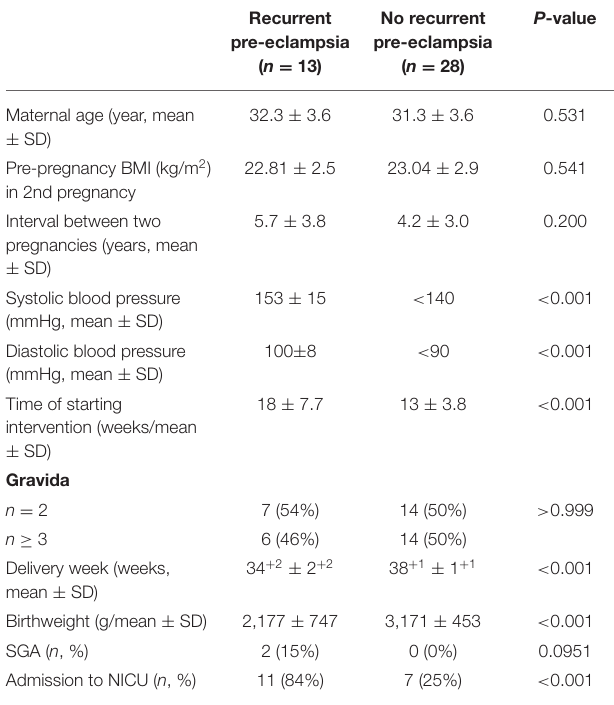
TABLE 1 | Clinical parameters of patients with and without recurrent